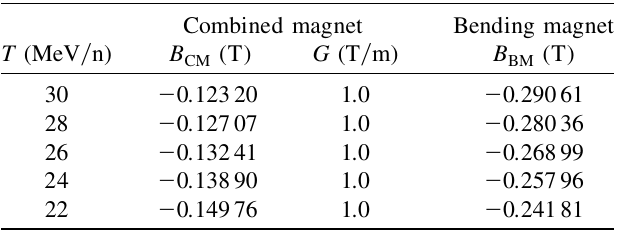
TABLE II. Focusing and bending fields for H The focusing and/or bending properties of the combined and bending magnets corresponding to the ion beams of different energies are given. The proton beams originating from H beams are strongly focused and slightly bent in the combined magnet. For T (cid:5) 20 MeV per nucleon a beam cannot be ex- tracted without losses.